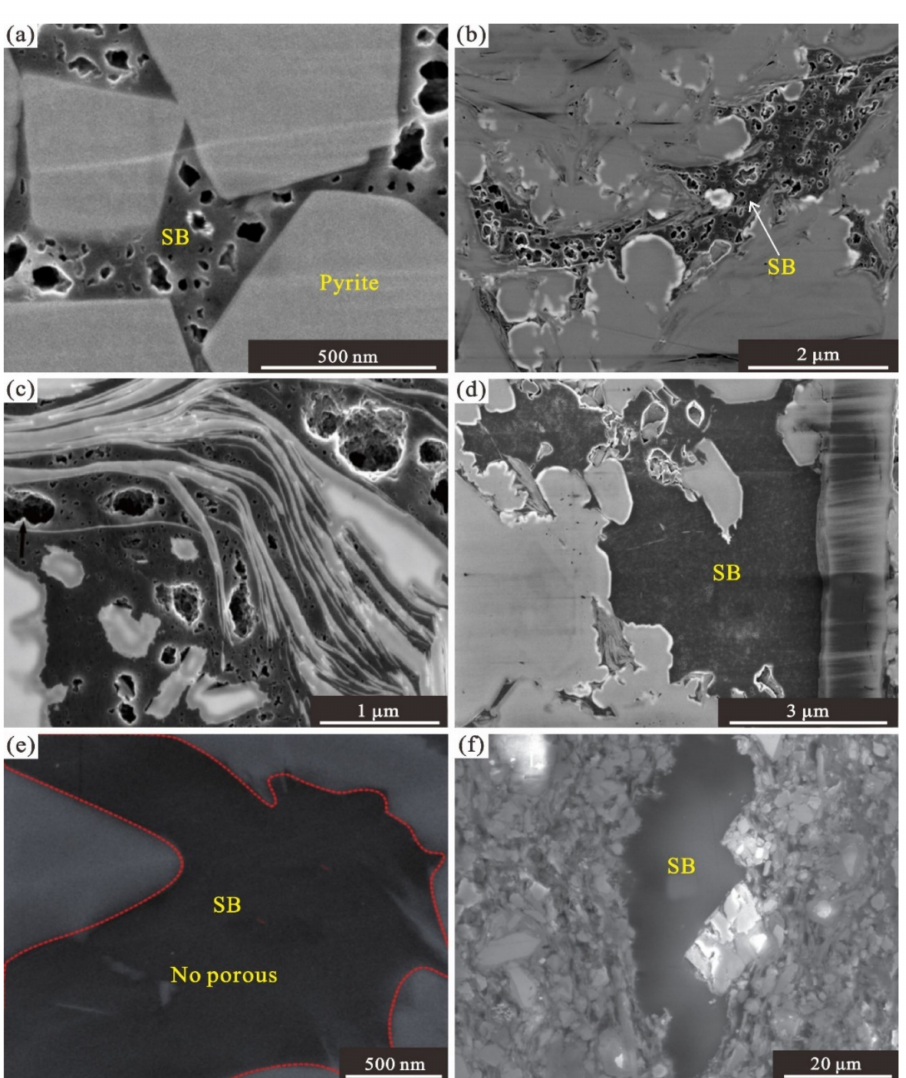
Figure 2. SEM photographs showing pore characteristics of solid bitumen. (Explanation: SB = solid bitumen.) ( a , b ) Nanopores are widely developed in the SB of the Longmaxi Formation shale from Well QJ-1 in the Northern Guizhou area (unpublished data). ( c ) Pores in the SB of Longmaxi Formation shale from the Sichuan Basin show complex morphologies [50]. ( d ) Pores are poorly developed in the SB of Lower Cambrian shale from Well HY-1 (unpublished data). ( e ) Pores are poorly developed in the SB of Niutitang Formation shale from Well CY-2 in the southeastern Chongqing area [85]. ( f ) No SEM-visible pores can be observed in the SB of New Albany shale